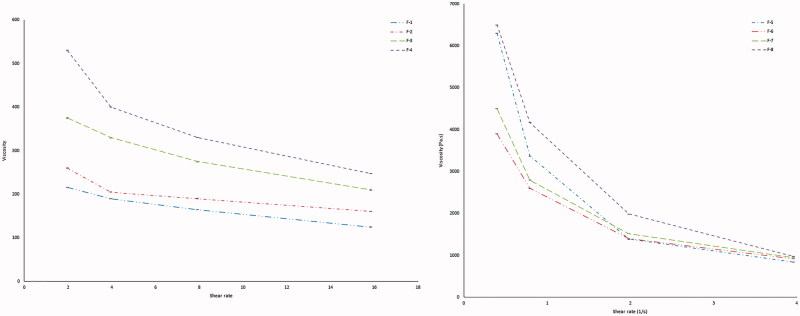
Viscosity of sols of different GBP formulae.